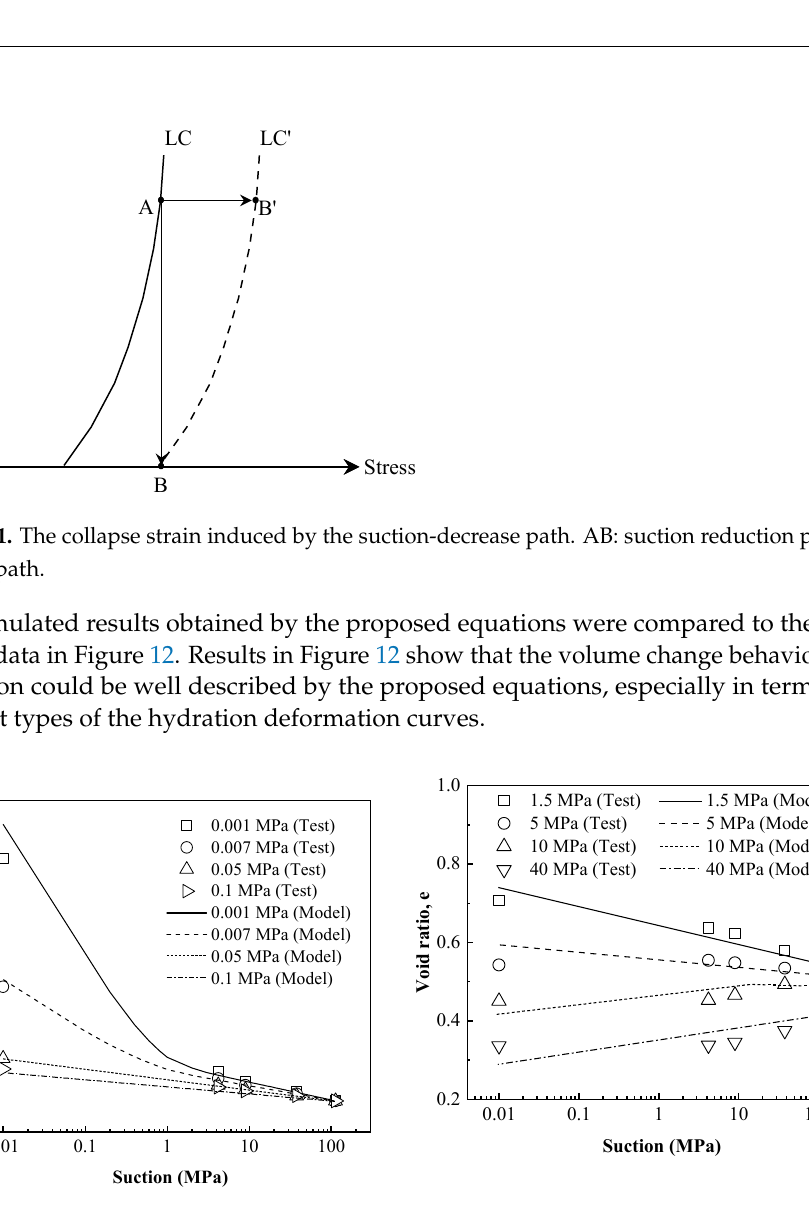
Figure 12. Simulations of swelling deformation tests conducted on compacted GMZ bentonite. ( a ) 0.001~0.1 MPa. ( b ) 1.5~40 MPa